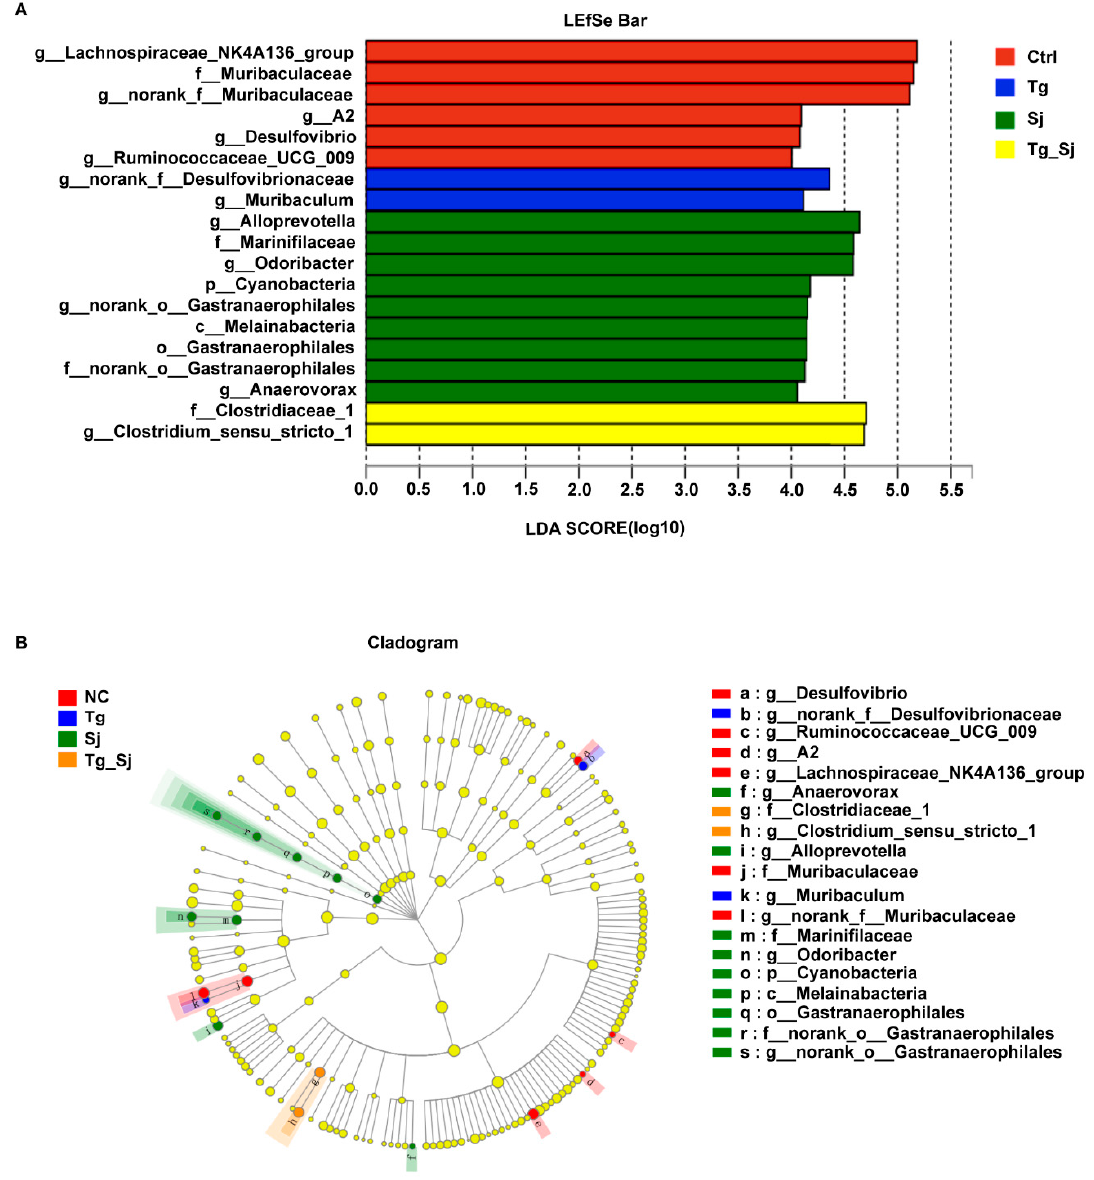
Figure 6. The most differentially abundant taxa identified by LEfSe in mice. ( A ) LDA score distribution among control (Ctrl), T. gondii (Tg), S. japonicum (Sj)-infected and co-infected (Tg_Sj) groups. ( B ) Cladogram of the most differentially abundant taxa in different groups. Only taxa meeting a histogram of linear discriminant analysis (LDA) significance threshold >4 are shown in the figures.